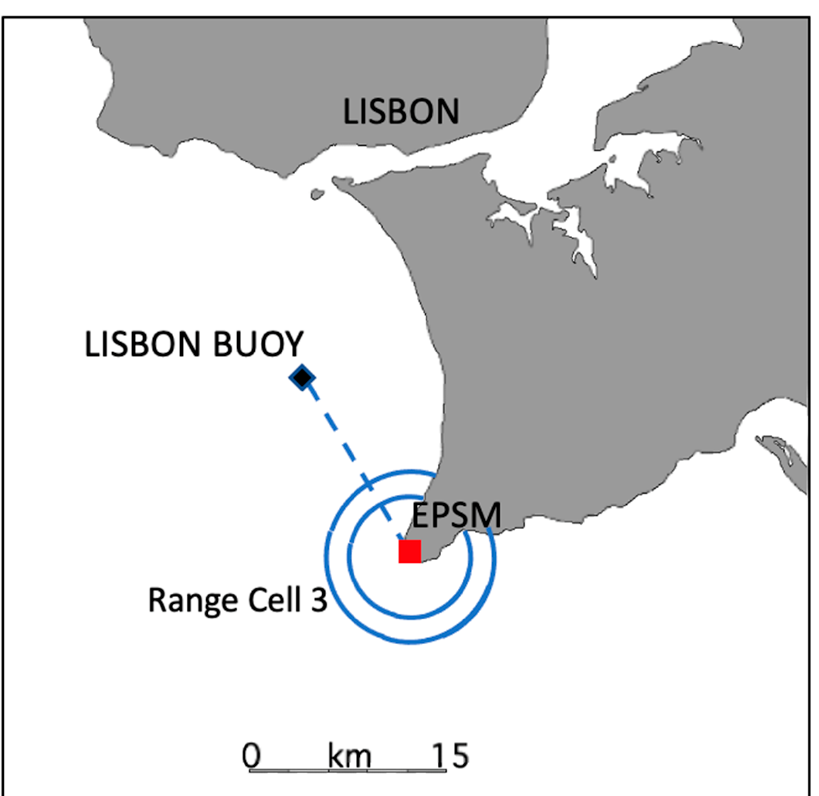
Figure 9. The coastline around the SeaSonde located at Espichel (EPSM), Portugal, showing the positions of the radar and the Lisbon buoy. Also shown is Range-cell 3 of width 2.15 km: Radar echo from Range-cell 3 was analyzed to give the following wave results. (i) and (ii) calculated from the radar monopole spectra.